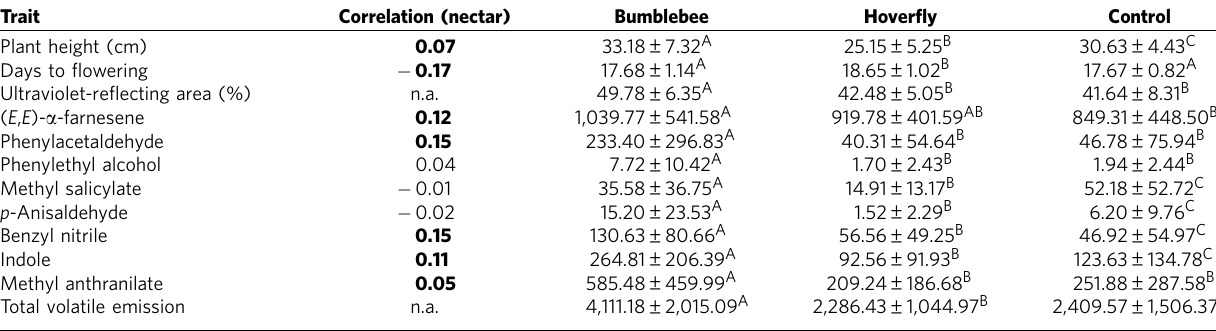
Table 1 | Traits that evolved differences between plants during the experiment. Trait